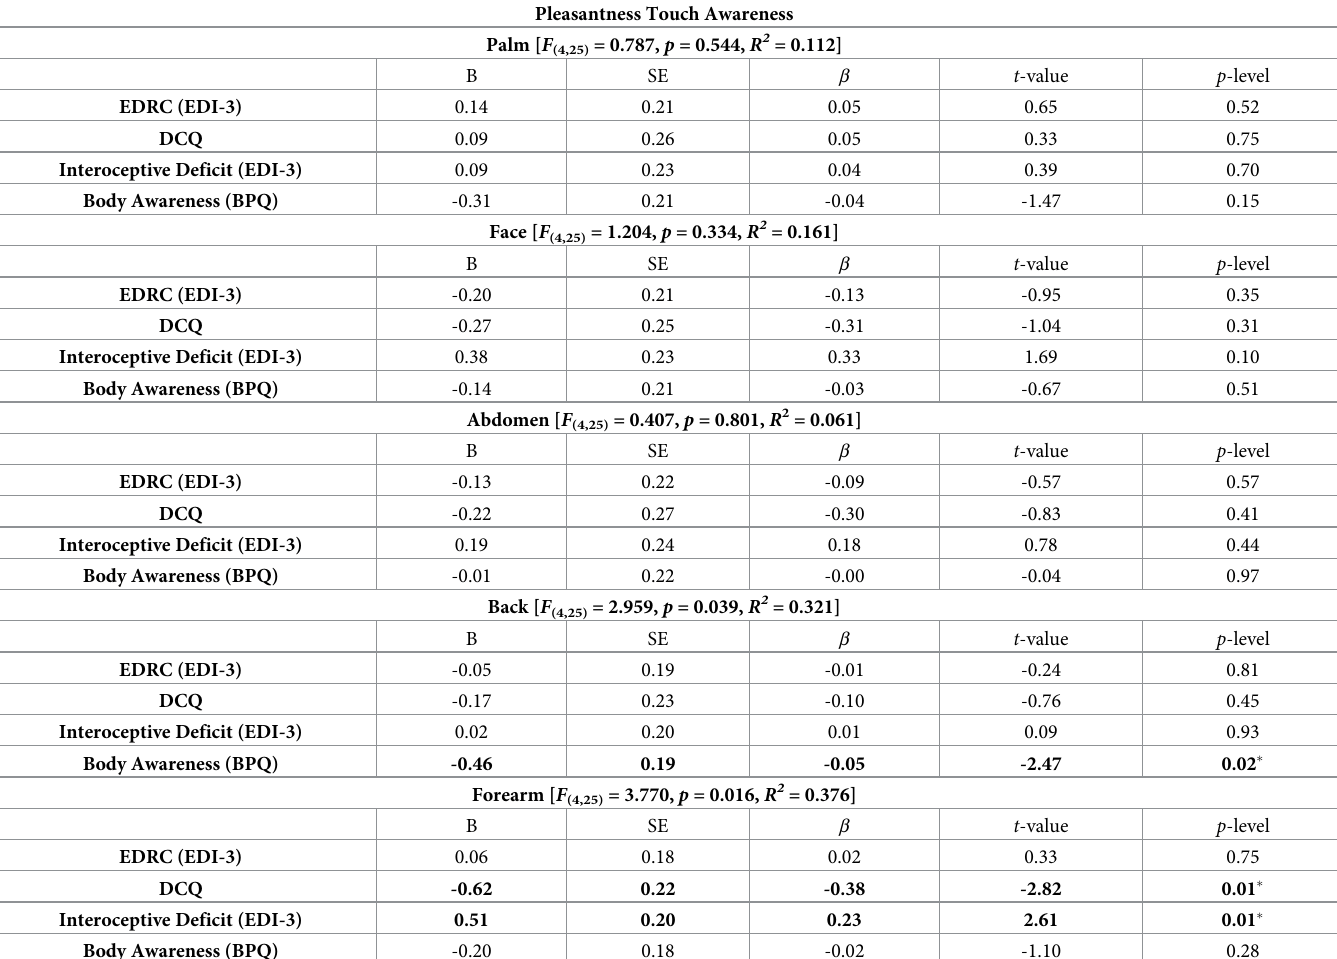
Table 2. Unstandardized coefficients from the linear simultaneous multiple regression models of eating and dysmorphic concerns and body awareness predictors of the pleasantness touch awareness (PTA) index at each body site (palm, face, abdomen, back and